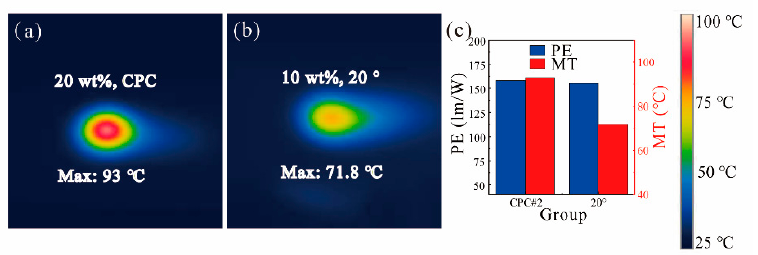
Figure 9. Temperature distribution of ( a ) the ATFPC; ( b ) the CPC; ( c ) PE of ( a ) the ATFPC; ( b ) the CPC.